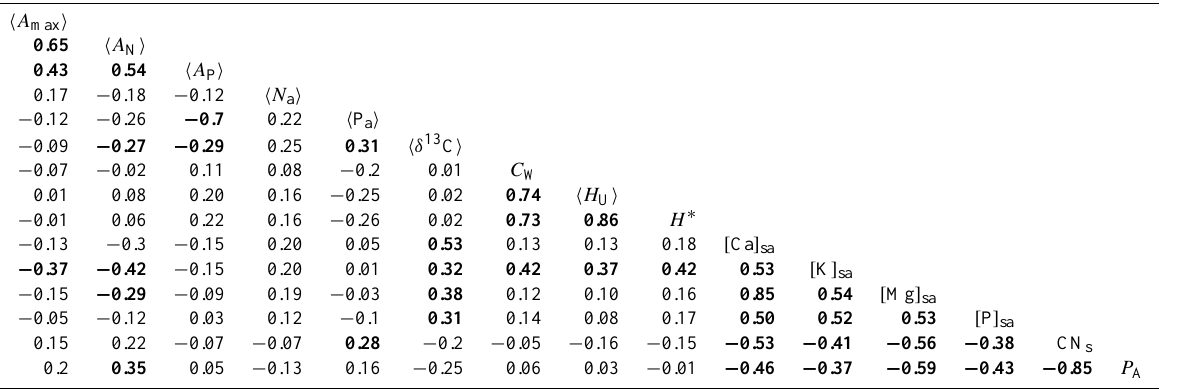
Table 1. Kendall’s bivariate correlation coefficients for stand-level photosynthetic capacity (cid:104) A max (cid:105) , photosynthetic nitrogen use efficiency (cid:104) A N (cid:105) , photosynthetic phosphorus-use efficiency (cid:104) A P (cid:105) and their association with a range of canopy, soil and climatic factors, viz. community- weighted means of area-based leaf nitrogen (cid:104) N a (cid:105) and phosphorus (cid:104) P a (cid:105) concentrations; leaf carbon stable isotopic composition (cid:104) δ 13 C (cid:105) ; total woody canopy area index C W ; upper 0.95 quantile upper-canopy height (cid:104) H U (cid:105) ; community-weighted mean upper-canopy height H ∗ ; area- based measures of soil nutrient availability for calcium, potassium and magnesium, viz. [ Ca ] sa , [ K ] sa and [ Mg ] sa ; soil carbon / nitrogen ratio (CN), and mean annual precipitation ( P A ). Values significant at p < 0 . 05 are shown in